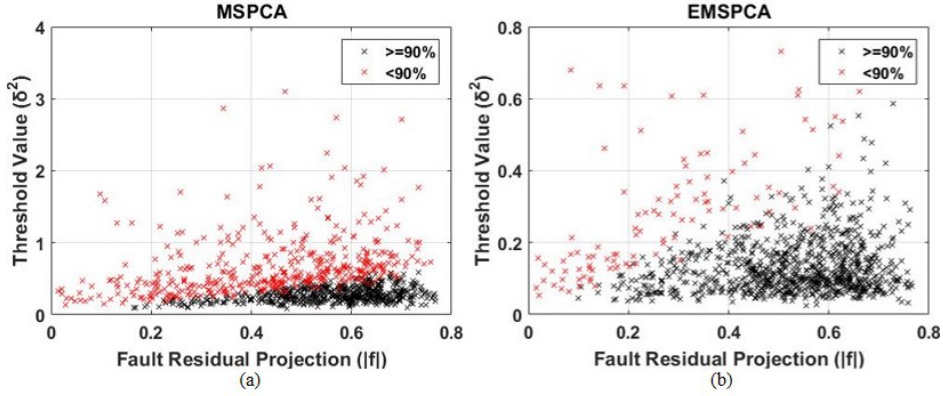
Figure 9. Scatter plot analysis of the relationship between threshold value and fault projection for MSPCA ( a ) and EMSPCA ( b ) for 90% success rate; depth of 4, a fault magnitude of 1 sigma, 1000 MC runs.